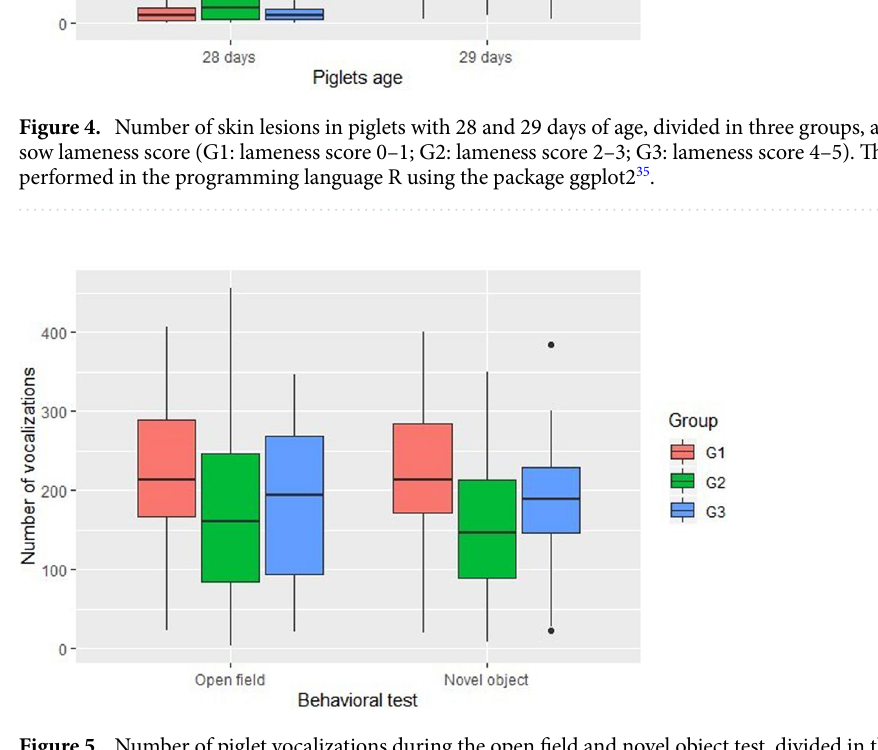
Figure 5. Number of piglet vocalizations during the open field and novel object test, divided in three groups, according to sow lameness score (G1: lameness score 0–1; G2: lameness score 2–3; G3: lameness score 4–5). This figure was performed in the programming language R using the package ggplot2 35